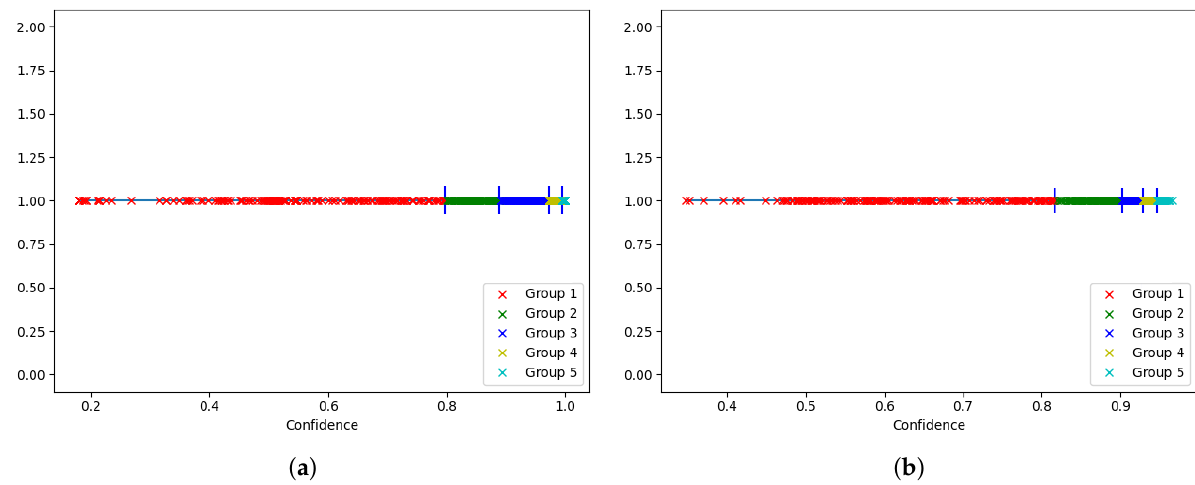
Figure 8. Grouping based on softmax confidence values. ( a ) Any-Precision. ( b )